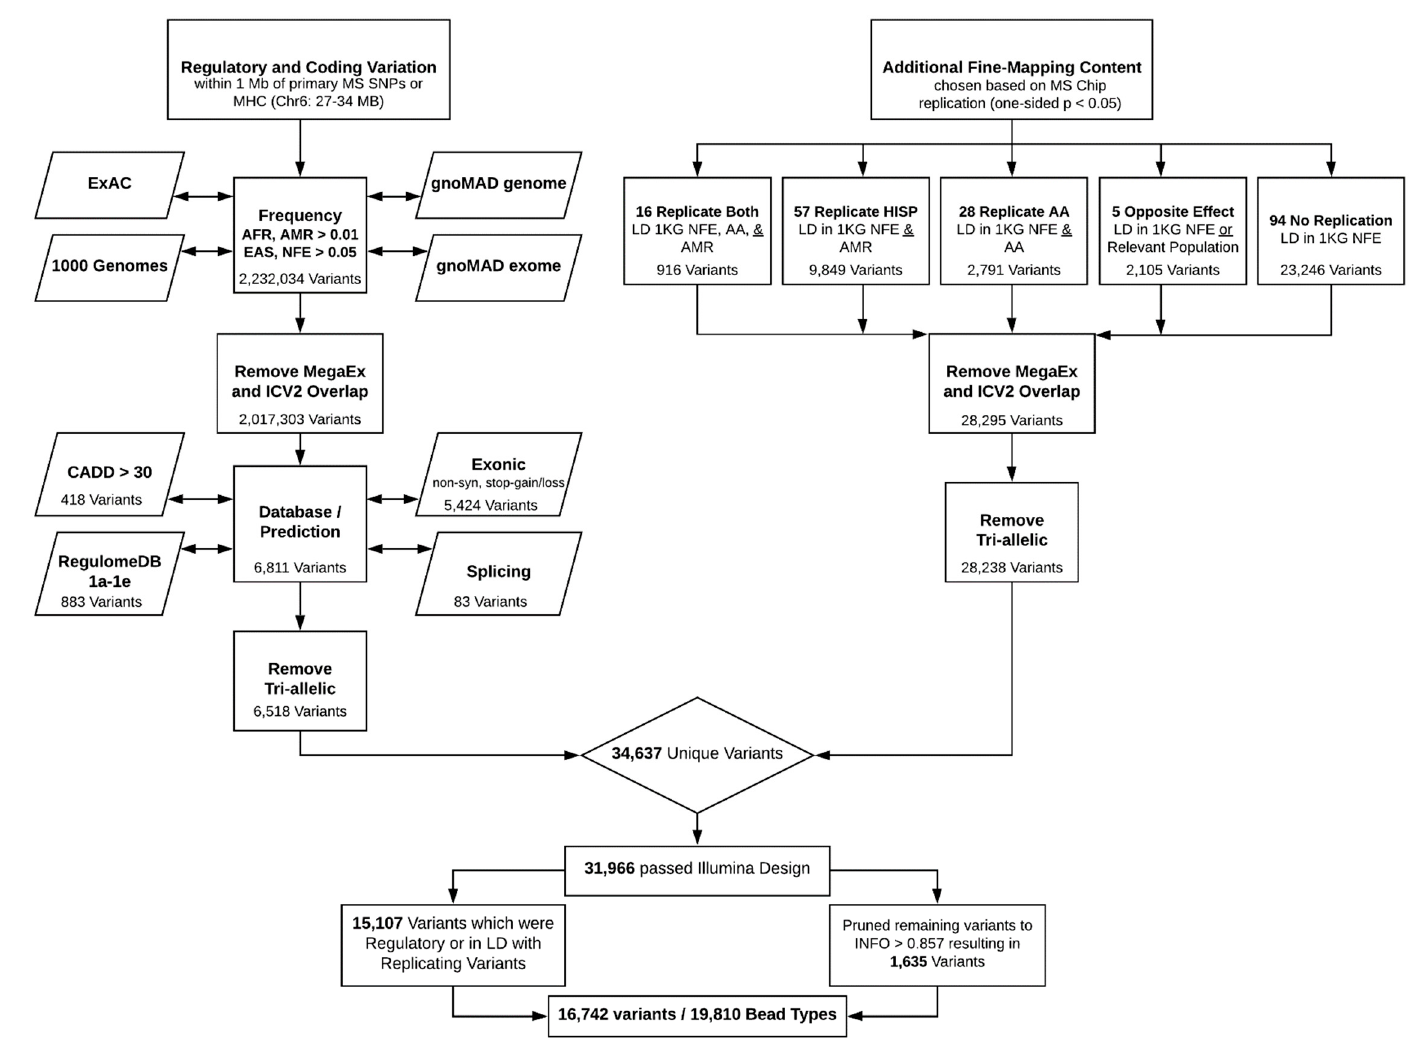
Figure 1. Workflow of variant selection for custom content.